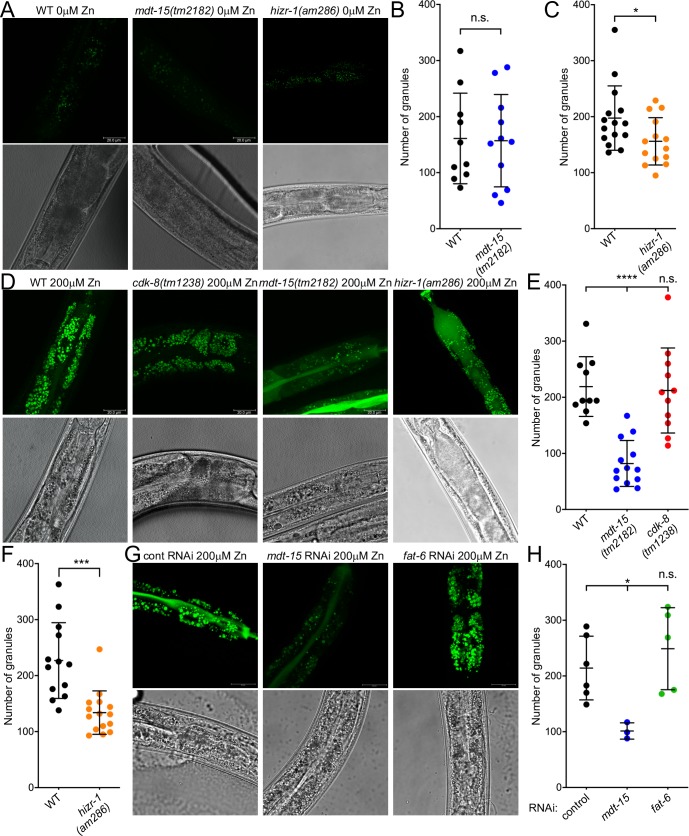
mdt-15(tm2182) mutants have a zinc storage defect.[A] Representative fluorescence and DIC micrographs of worms stained with FluoZin-3, showing zinc accumulation in the gut granules of wild-type (WT), mdt-15(tm2182), and hizr-1(am286) worms grown without zinc supplementation. [B-C] Quantification of the number of gut granules in wild-type (WT), mdt-15(tm2182), and hizr-1(am286) worms; every dot represents an individual worm. Error bars: standard deviation; n = 10 for WT in [B], 11 for mdt-15(tm2182); 15 for WT in [C]; 14 for hizr-1(am286) (totals from 3 independent repeats for [B] and 4 for [C]). Statistical analysis: * p < 0.05, n.s. = not significant, unpaired Student’s t-test, comparisons to WT. [D] Representative fluorescence and DIC micrographs of worms stained with FluoZin-3, showing zinc accumulation in the gut granules of wild-type (WT), mdt-15(tm2182), cdk-8(tm1238), and hizr-1(am286) worms grown with 200μM zinc supplementation. [E] Quantification of the number of gut granules in wild-type (WT), mdt-15(tm2182), and cdk-8(tm1238) worms; every dot represents an individual worm. Error bars: standard deviation; n = 10 for WT, 13 for mdt-15(tm2182), 11 for cdk-8(tm1238) (totals from 3 independent repeats). Statistical analysis: **** p < 0.0001, One-way ANOVA, multiple comparisons, Dunnett correction, compared to “WT”. [F] Quantification of the number of gut granules in WT and hizr-1(am286) worms; every dot represents an individual worm. Error bars: standard deviation; n = 13 for WT, 15 for hizr-1(am286) (totals from 4 independent repeats). Statistical analysis: *** p < 0.001, unpaired Student’s t-test, compared to “WT”. [G] Representative fluorescence and DIC micrographs of worms fed control (empty vector L4440), mdt-15, or fat-6 RNAi and stained with FluoZin-3, showing zinc accumulation in the gut granules of worms grown with 200mM zinc supplementation.[H] Quantification of the number of gut granules in worms fed control, mdt-15, or fat-6 RNAi; every dot represents an individual worm. Error bars: standard deviation. n = 6 for control (2 independent repeats), 3 for mdt-15 (1 repeat), and 5 for fat-6 (2 independent repeats). Statistical analysis: * p < 0.05, n.s. = not significant, One-way ANOVA, multiple comparisons, Dunnett correction, compared to control RNAi.